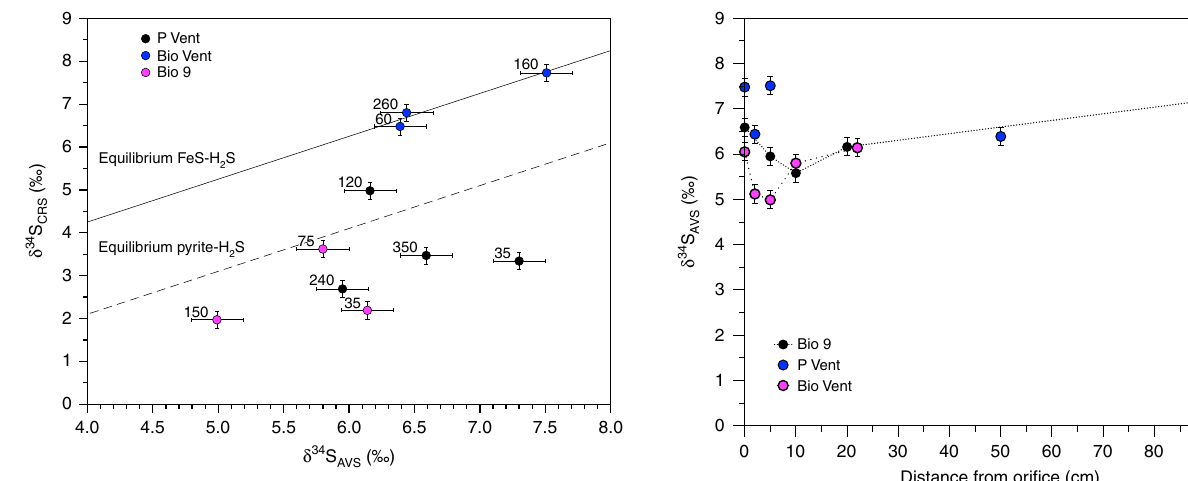
Fig. 3 Sulphide isotopic composition in the buoyant plume. δ 34 S AVS (un fi ltered) with increasing distance from the vent ori fi ce in the plume. Error bars represent one standard deviation